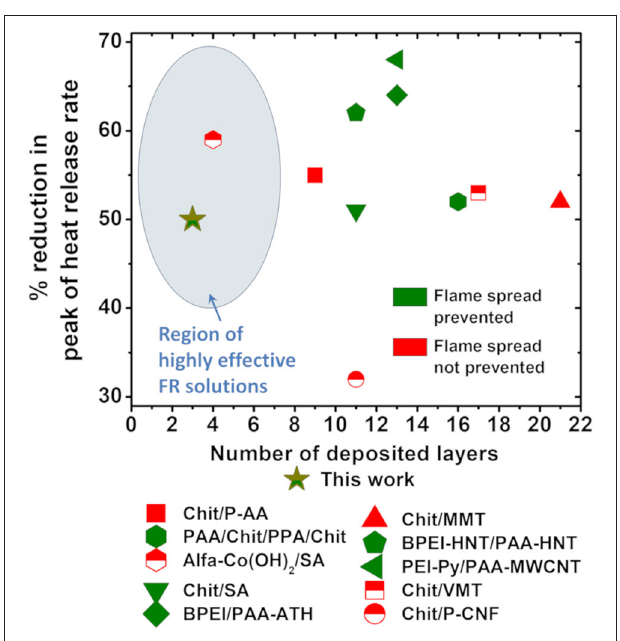
FIGURE 7 | Comparison of the flame-retardant performance in terms of peak of heat release reduction during cone calorimetry tests (35 kW/m 2 ). In the legend, Chit, chitosan; P-AA, phosphonated allylamine; PAA, poly(acrylic acid); PPA, poly(phosphoric acid); SA, sodium alginate; BPEI, branched polyethyleneimine; ATH, aluminum trihydroxide; MMT, montmorillonite; HNT, halloysite nanotubes; PEI-Py, pyrene functionalized polyethyleneimine; MWCNT, multi wall carbon nanotubes; VMT, vermiculite; P-CNF, phosphorylated cellulose